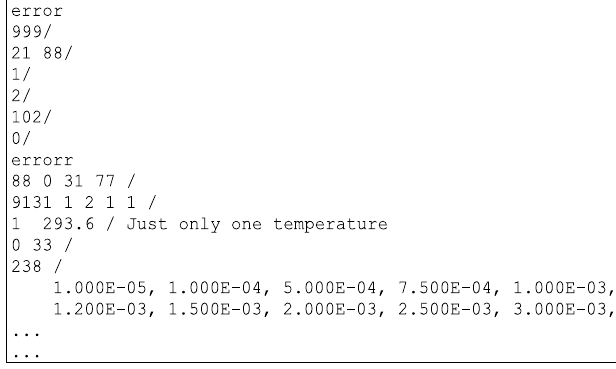
Fig. 6. NJOY input to process fi les with only